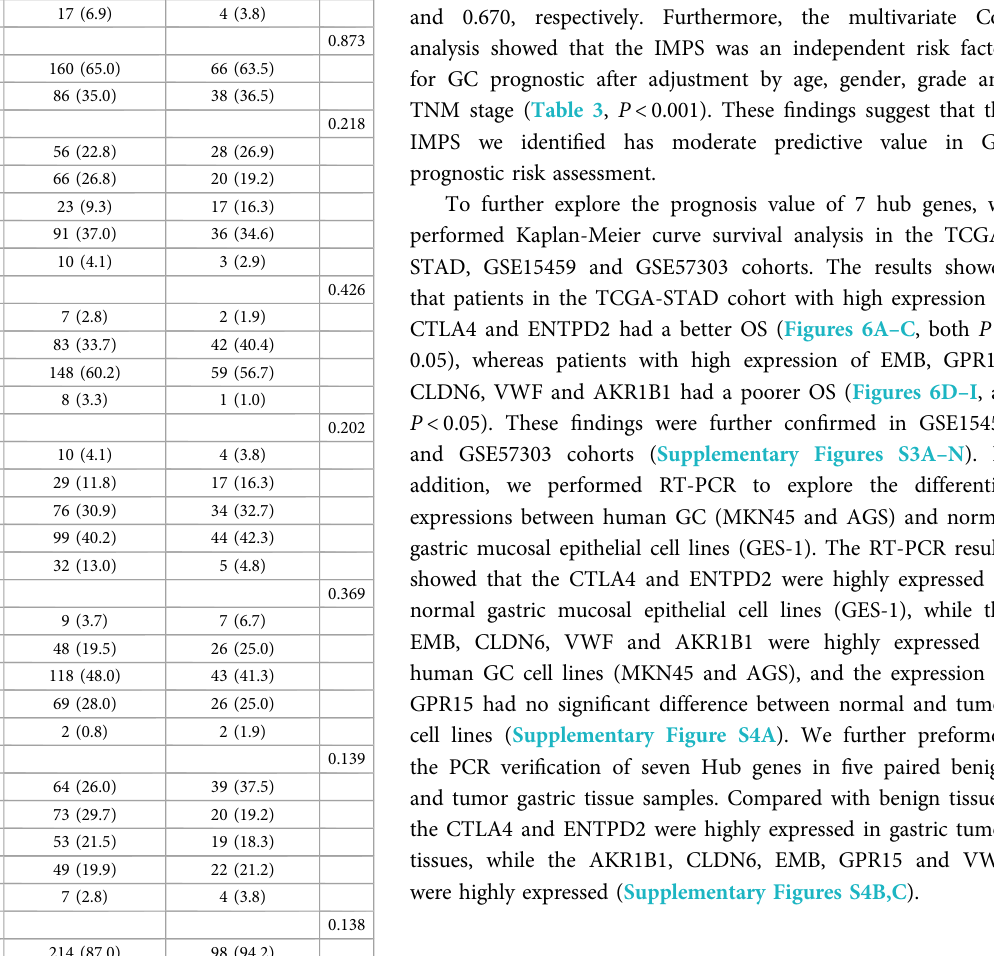
( Supplementary Figure S2B ) and GSE34942